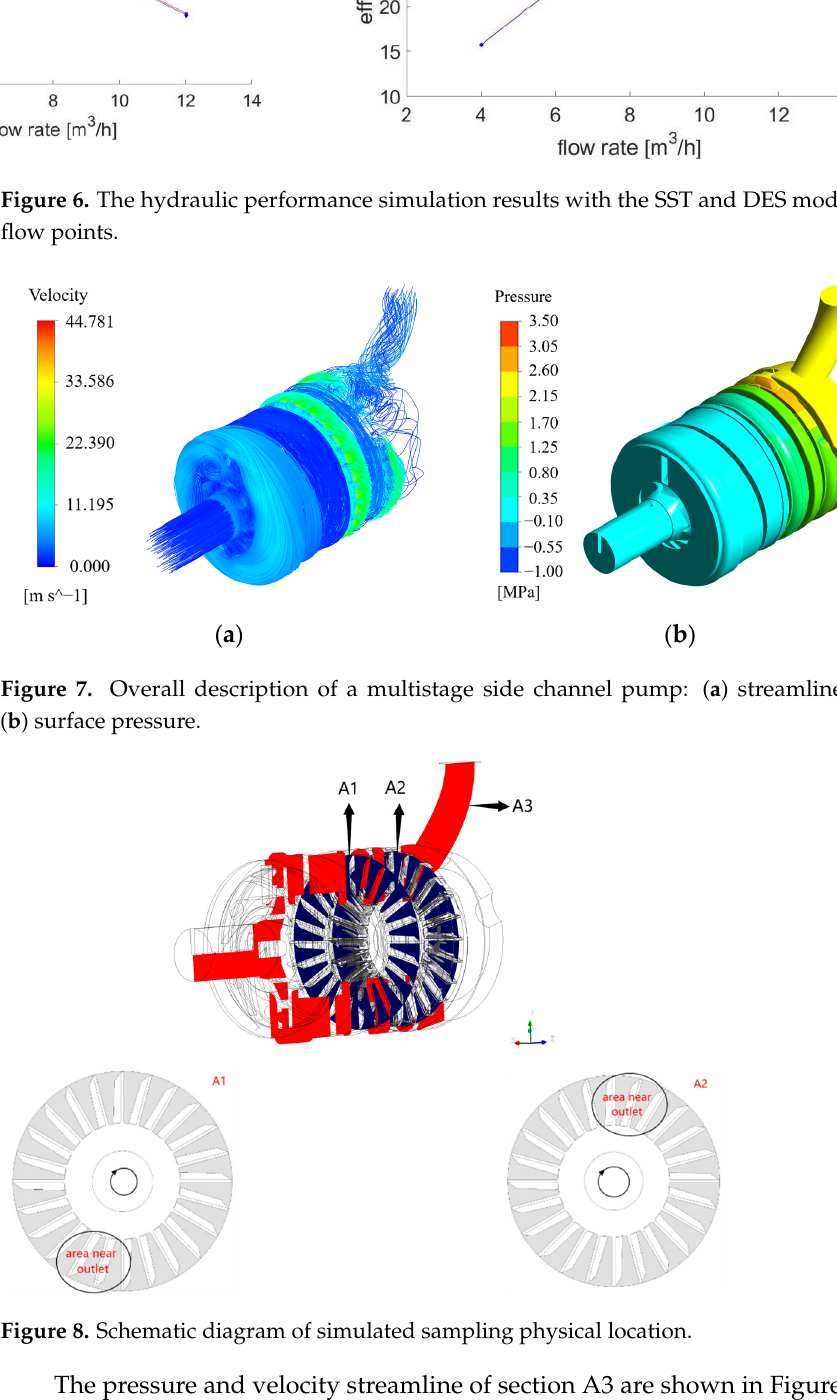
Figure 8. Schematic diagram of simulated sampling physical location.